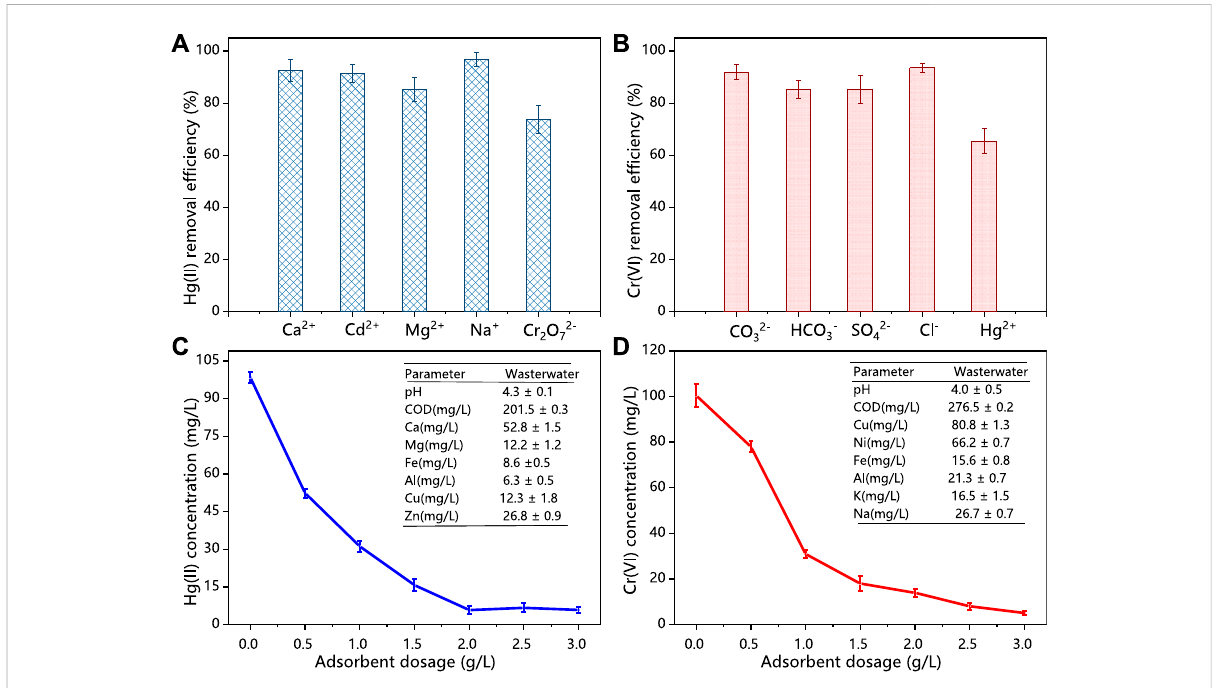
FIGURE 6 (A) Adsorption of Hg (II) by HCSS toward the mixture of metal ions. (B) Adsorption of Cr (VI) by HCSS toward the mixture of negatively charged ions. Conditions: concentration of competitive ions: 200 ppm; sample volume: 10 ml; dosage: 0.5 g/L; reaction time: 24 h; pH: 6.5;